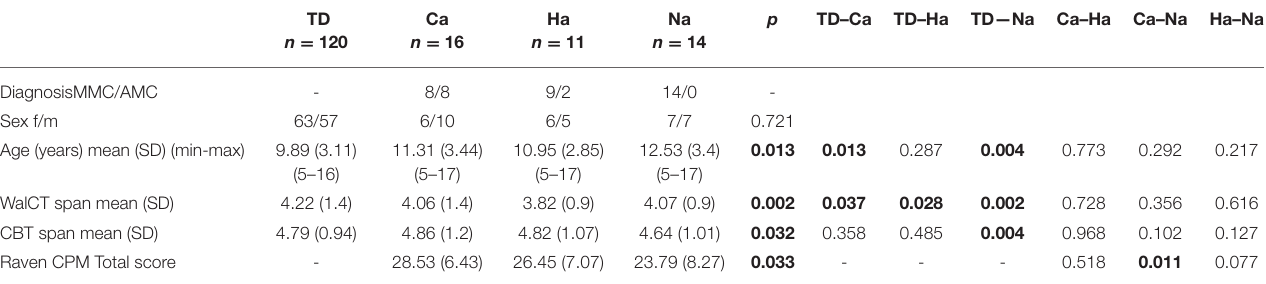
TABLE 1 | Demographics, mean, standard deviations (SD), age and spans of WalCT and CBT, and distribution of ambulation with respect to participants with MMC and AMC.